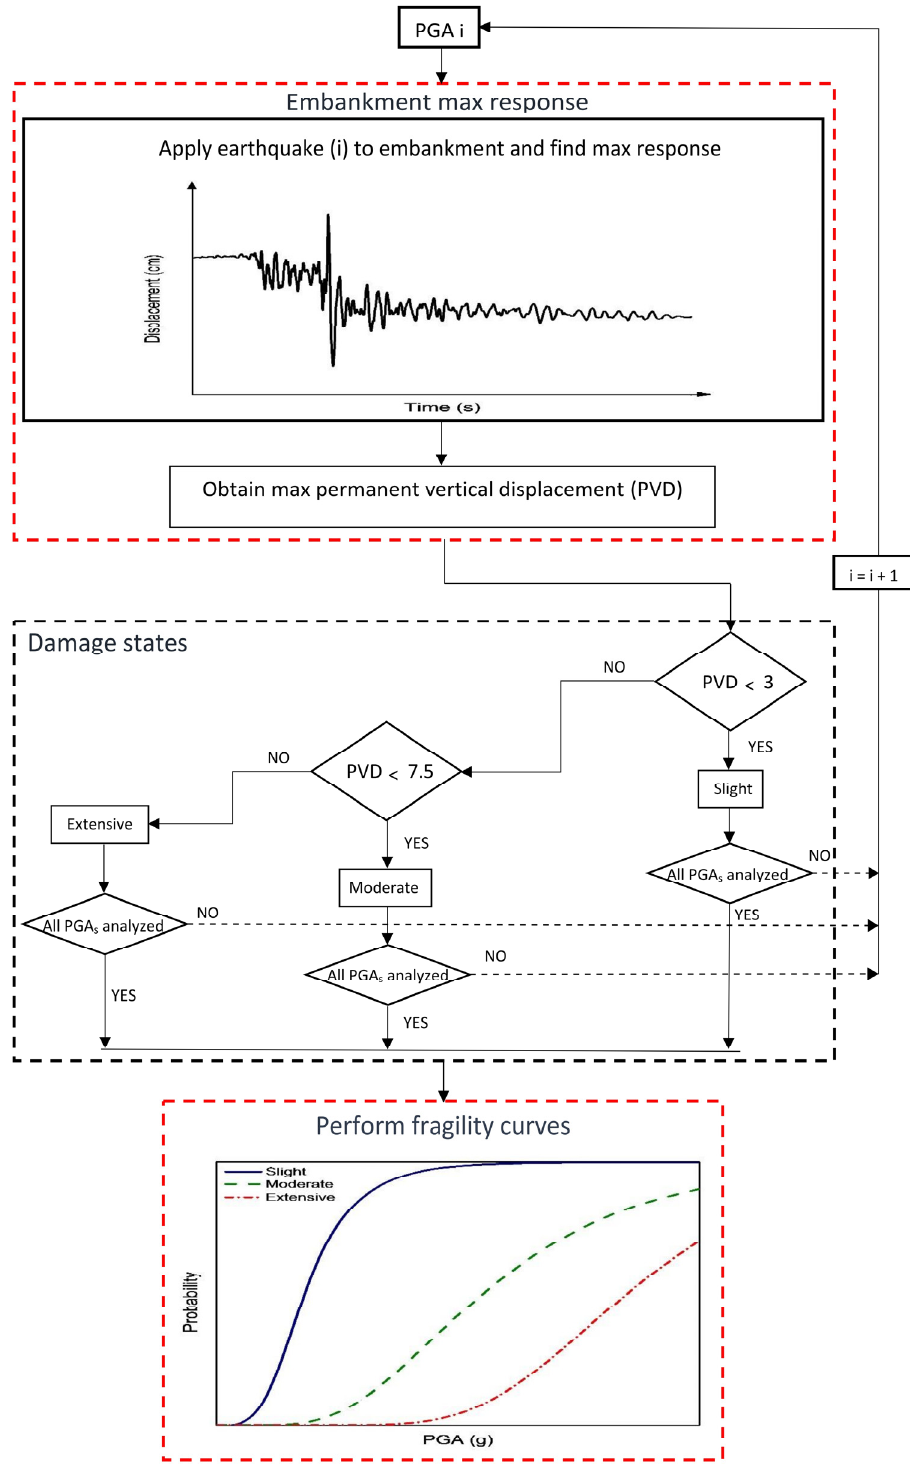
Figure 1. The framework of the proposed method.